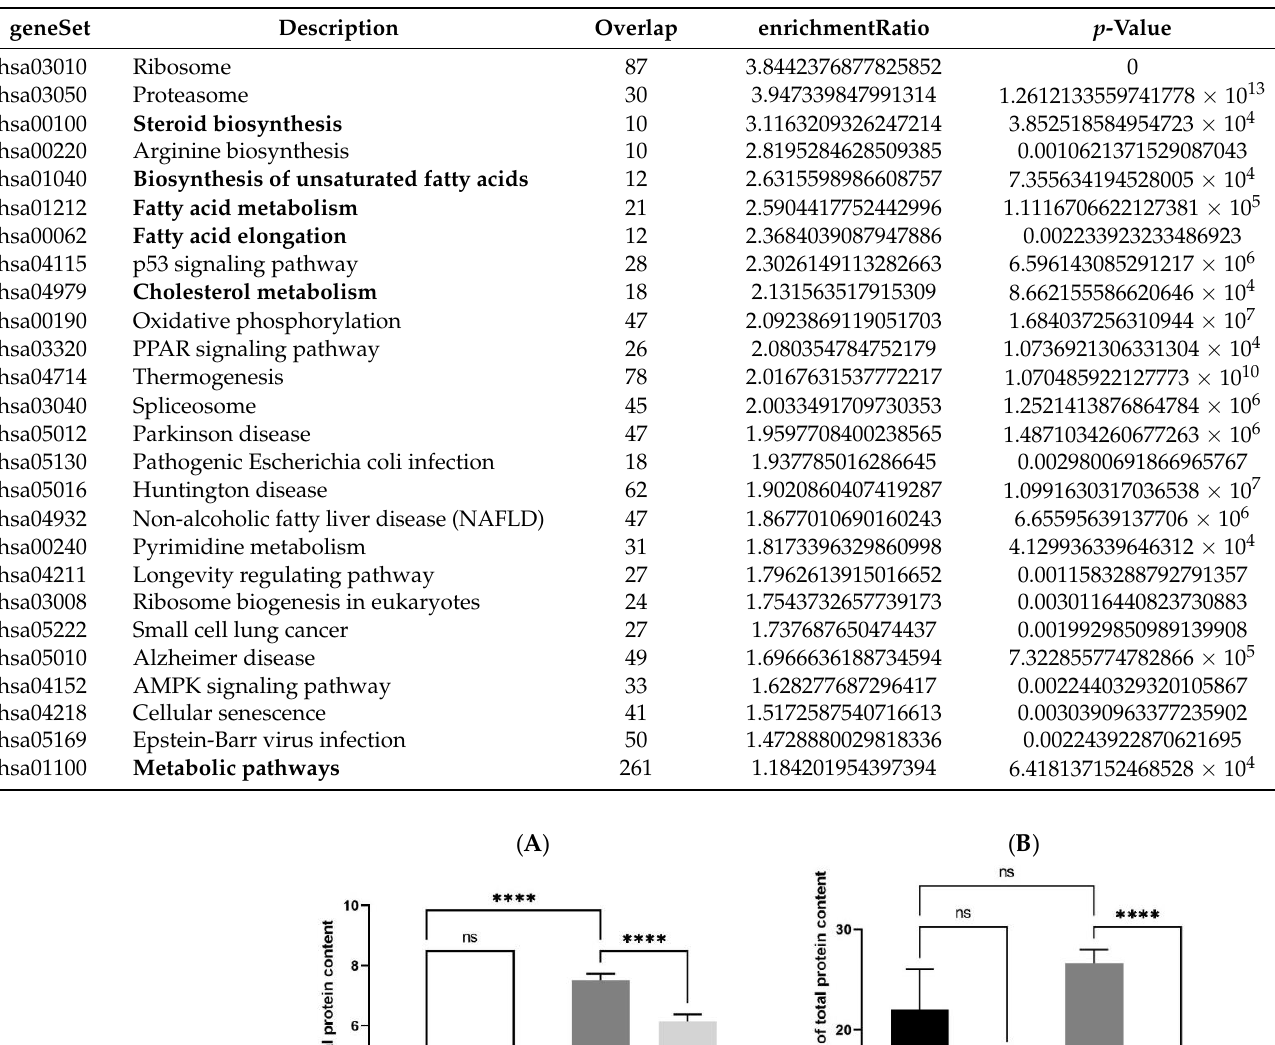
Table 1. Enrichment ratio within gene clustering.